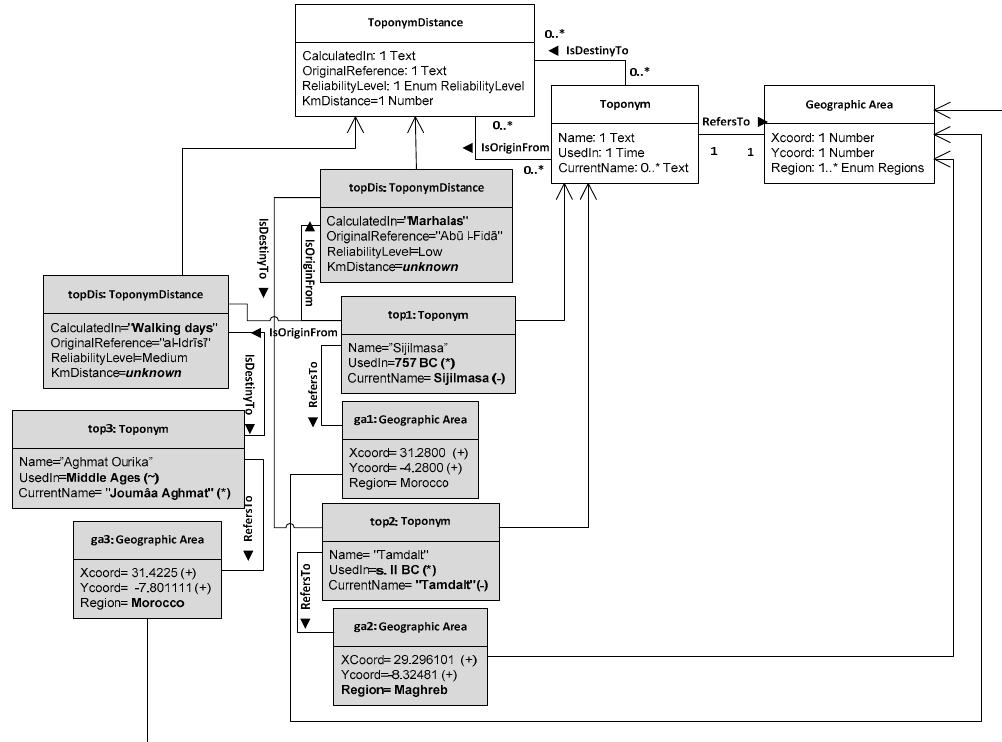
Figure 2. ConML model for Sijilmasa, Tamdalt, and Aghmat Ourika toponyms information in DICTOMAGRED project. In grey, objects created for instantiate the class model, representing imprecise and uncertain information regarding toponym, ToponymDistance, and geographic